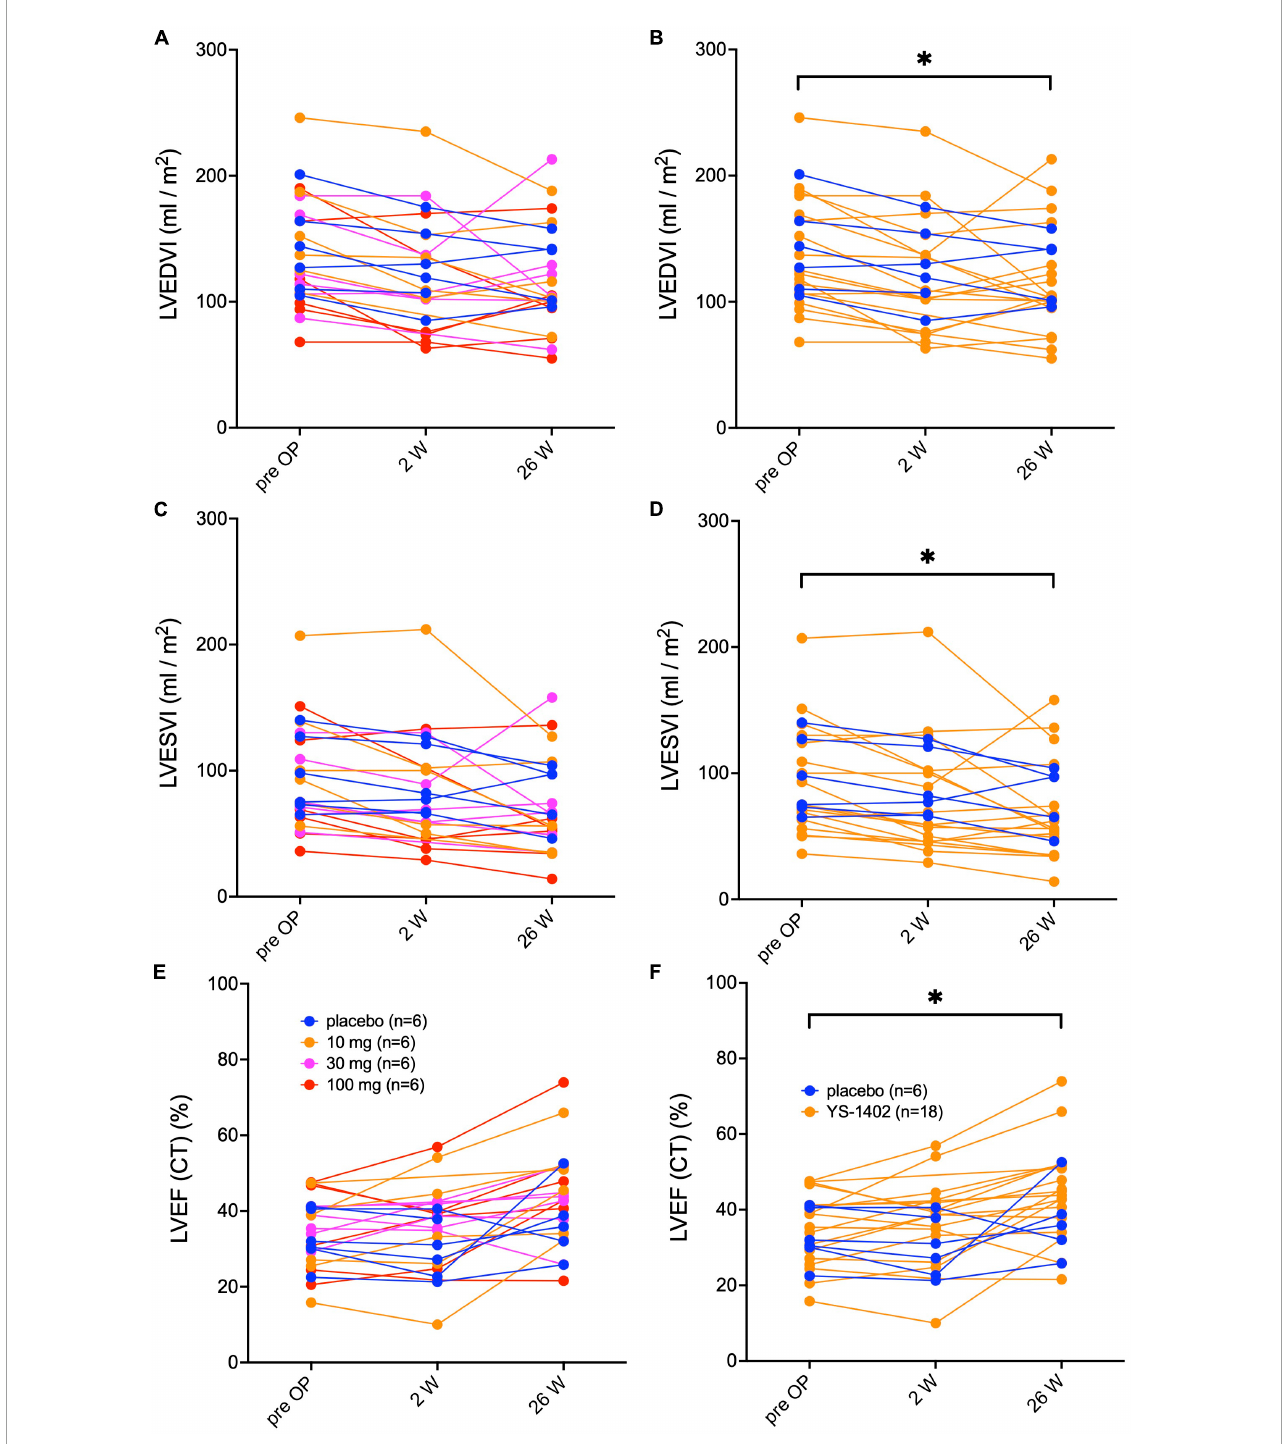
FIGURE2 Serial assessments of left ventricular volume and ejection fraction. Serial changes in the left ventricular end-diastolic volume index (LEVI) in each of the four groups (A) and in the combined YS-1402/placebo group (B) , the ventricular end-systolic volume index (LVESVI) in each of the four groups (C) and in the combined YS-1402/placebo group (D) , and the left ventricular ejection fraction (LVEF) in each of the four groups (E) and in the combined YS-1402/placebo group (F) , measured using cardiac computed tomography. The data are presented for each patient. ∗ p < 0.05 in the YS-1402 group between the preoperative and postoperative (i.e., at 26 weeks)